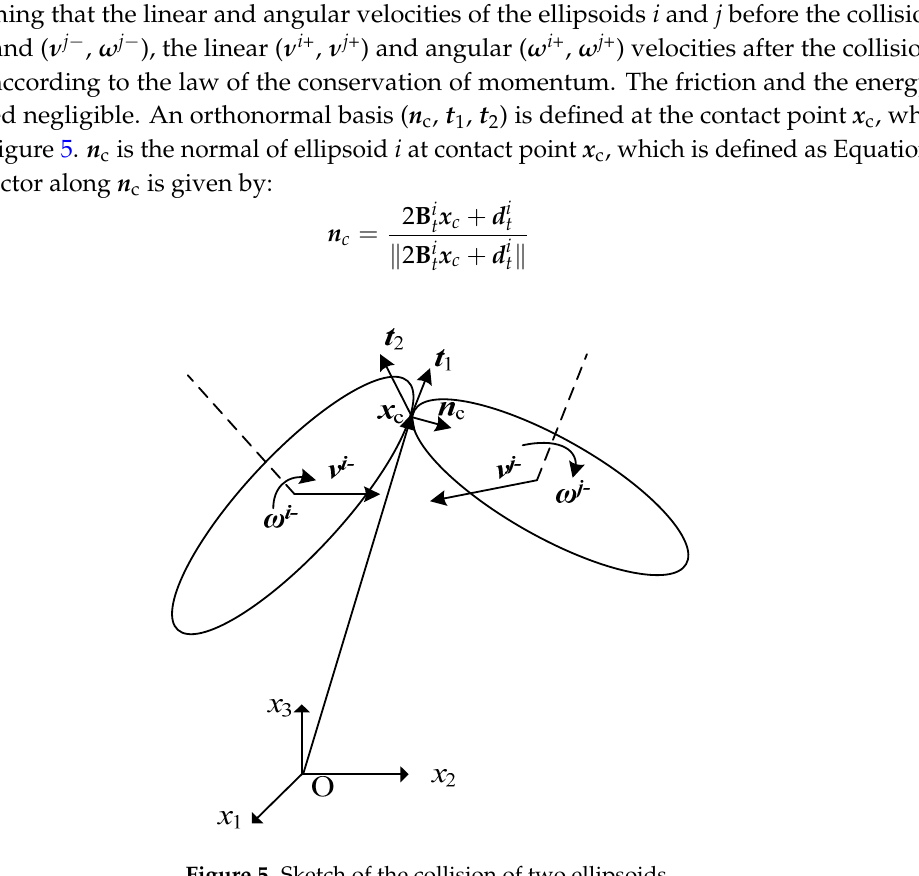
Figure 5. Sketch of the collision of two ellipsoids.